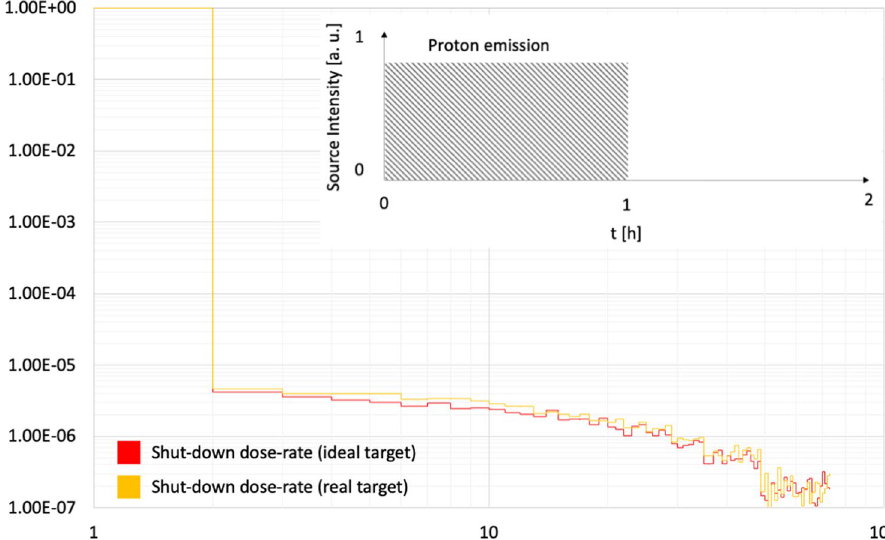
Figure 8. Normalized shut-down dose-rate from the end of beam up to 72 h. Red, ideal target. Yellow, real target. Y-scale in arbitrary units. X axis, time